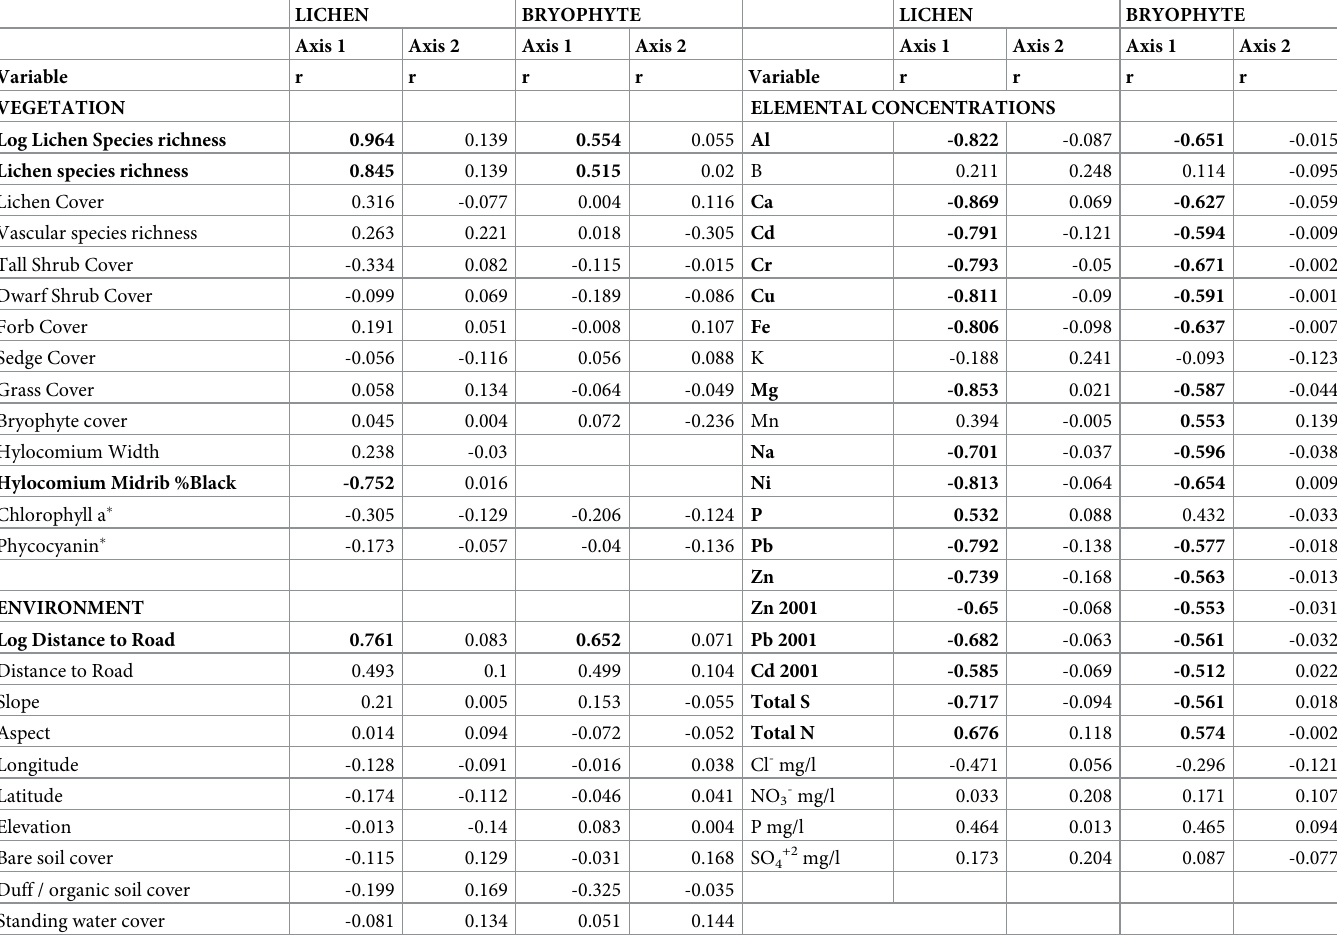
Table 2. Spearman correlation coefficients (r) of environmental variables for two NMS ordinations on transect plots out to 4000 m from DMTS haul road in CAKR: Lichen ordination (91 plots x 93 species) and bryophyte ordination (91 plots x 5 species groups). Values for which r > 0.5 are presented in